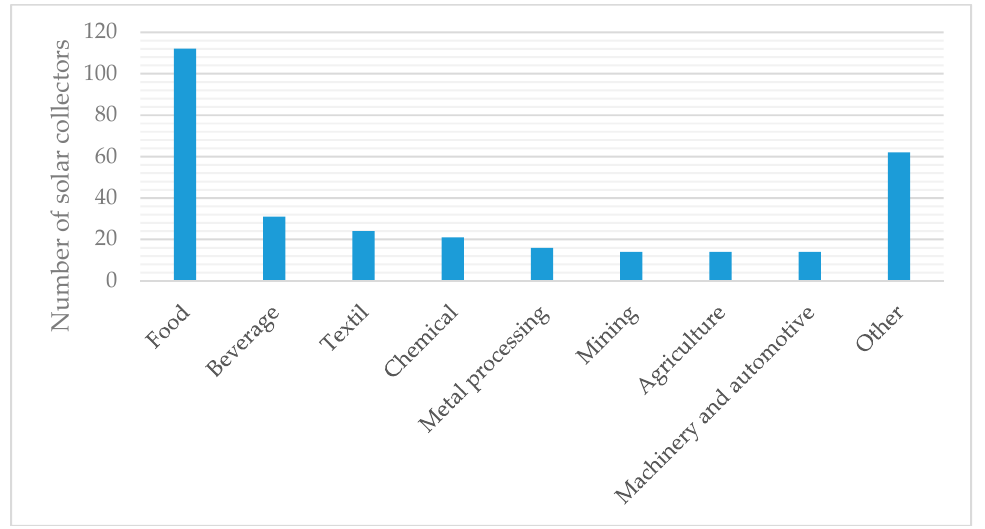
Figure 5. Distribution of industrial solar installations (numbers) by application [23].